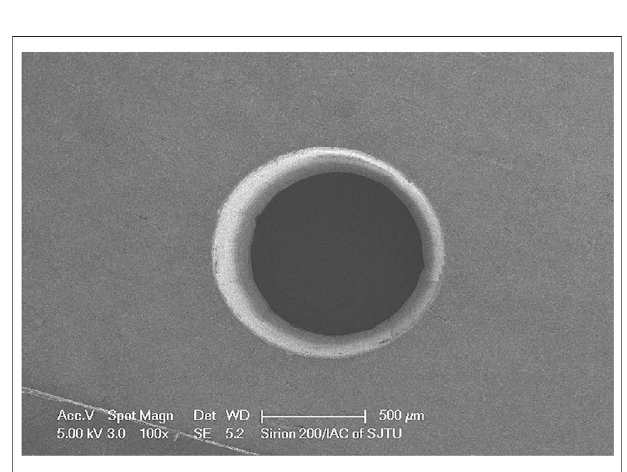
FIGURE 4 | SEM images of MI site preparation with 3.5 W average power laser, 170fs pulse duration (FWHM), 1 kHz repetition rate at 800 nm.